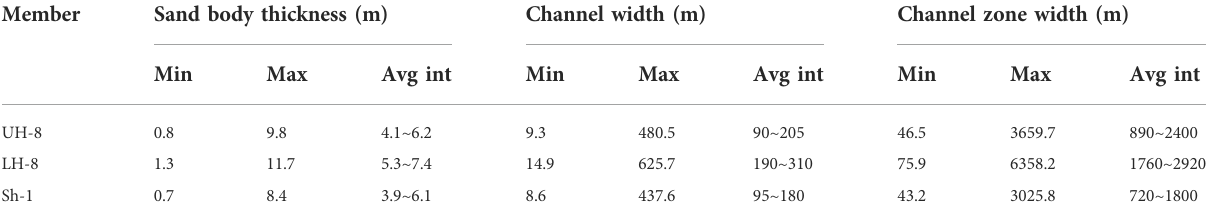
TABLE 2 Quantitative calculation results of distributary channel width in the study area.